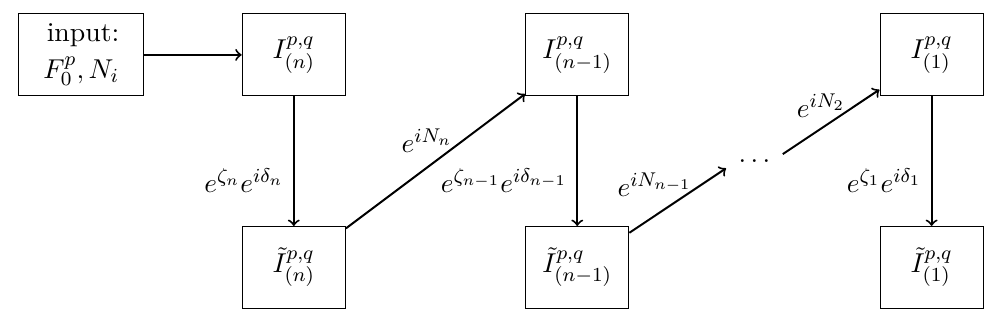
. We labelled each arrow by the ( k ) according to (3.45). In particular, each 0